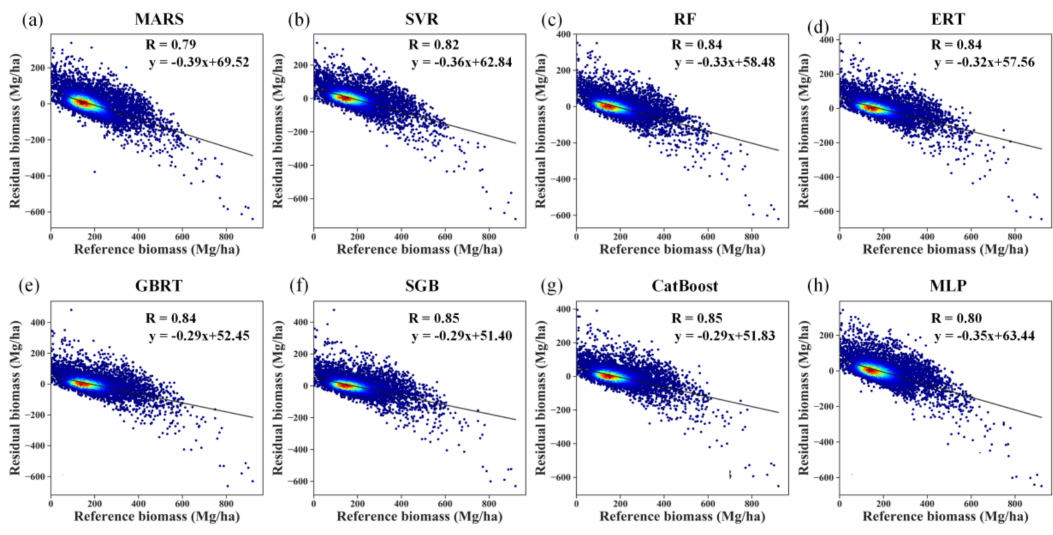
Figure 8. Residual analysis of di ff erent modeling results obtained by the MARS, SVR, RF, ERT, GBRT, SGB, CatBoost, and MLP algorithms ( a – h ) under the random sampling scenario without stratification of forest types.